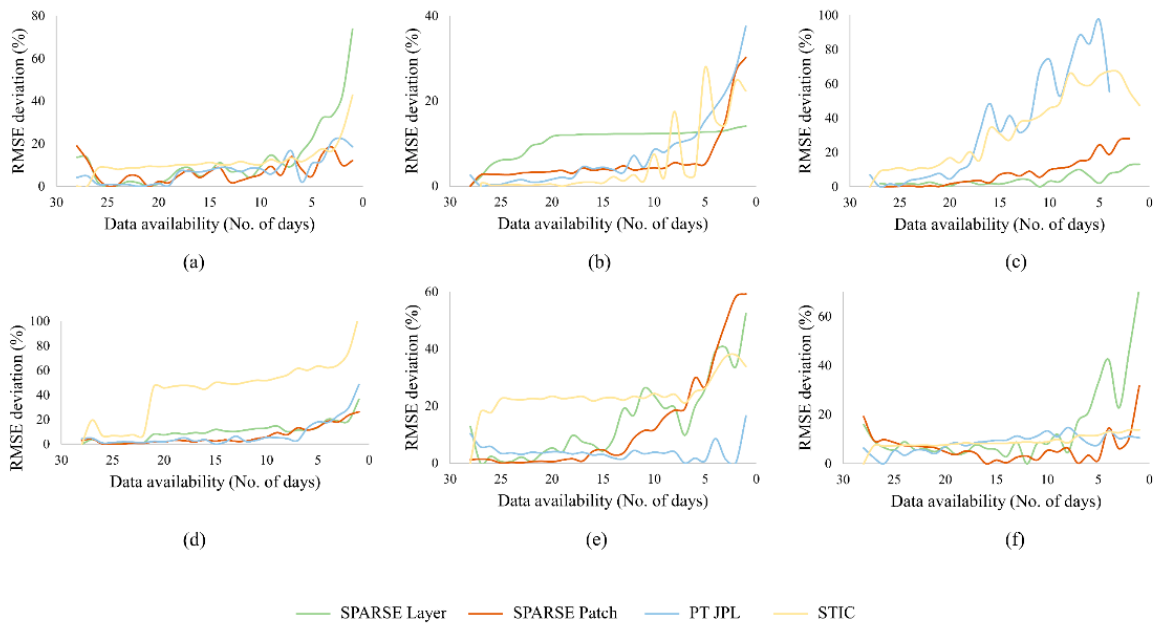
Figure 4. Plots of percentage increase in RMSE with respect to the minimum RMSE against number of days of data availability for the sites in: ( a ) Tunisia; ( b ) Aurad é ; ( c ) Lamasqu è re; ( d ) Nawagam; of days of data availability for the sites in: ( a ) Tunisia; ( b ) Auradé; ( c ) Lamasquère; ( d ) Nawagam; ( e ) Samastipur; and ( f ) ( e ) Samastipur; and ( f ) Jaisalmer.